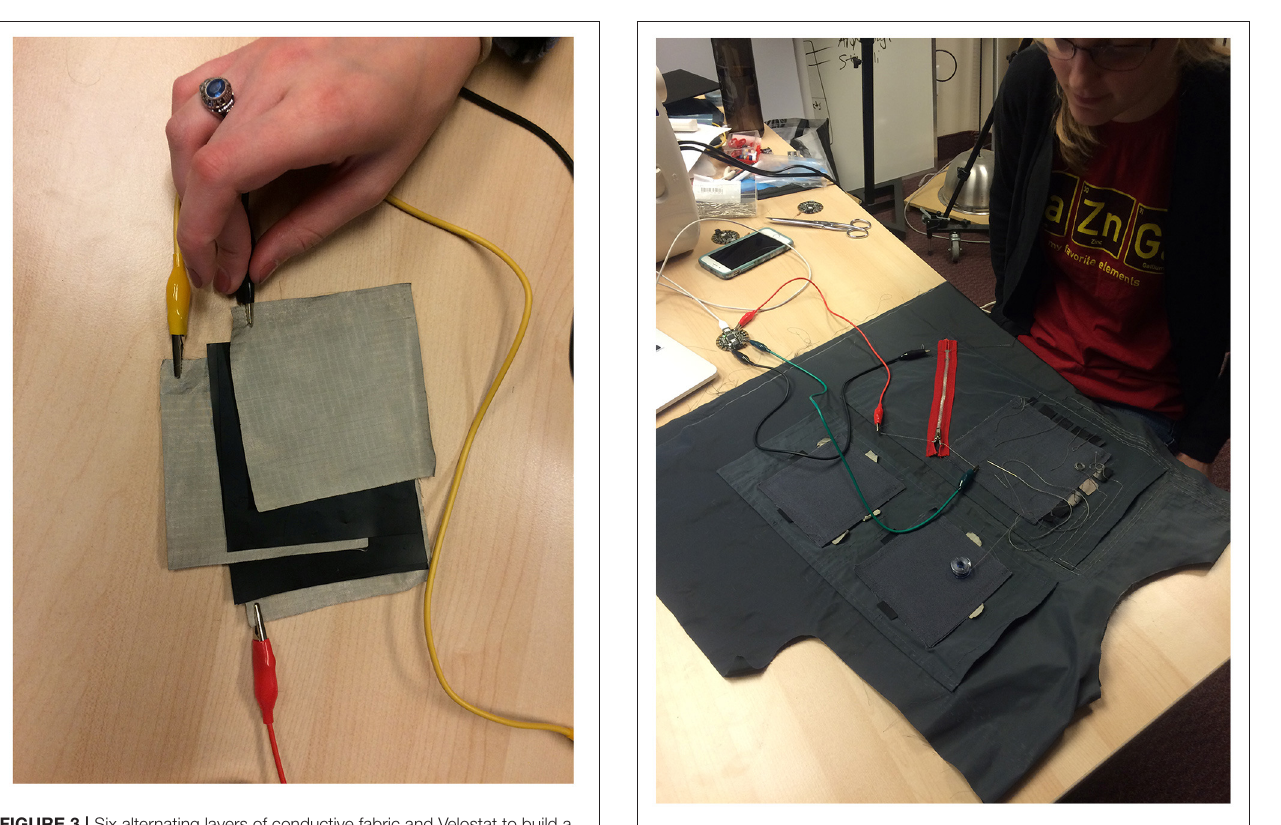
using the position of his finger on the pad. The Z value (pressure)